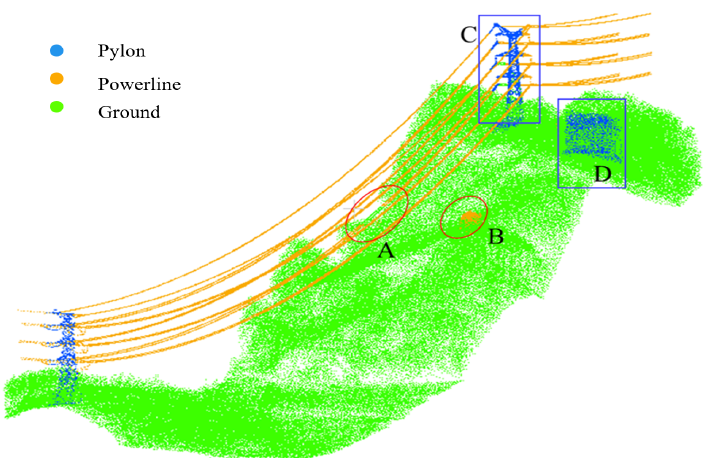
Figure 4. The coarse extraction of pylon and power line